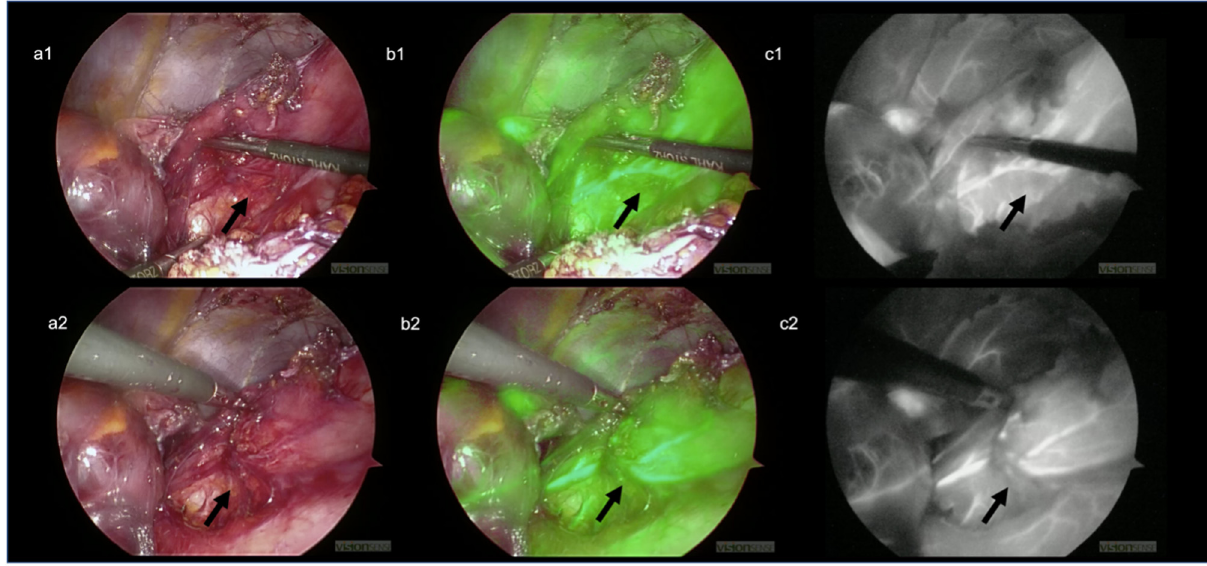
Figure 3. Exposure and easy visualization of the left gastric artery (arrow). ( a1 , a2 ) Visible-light image ( b1 , b1 ) green filter image ( c1 , c2 ) near-infrared (NIR) image.